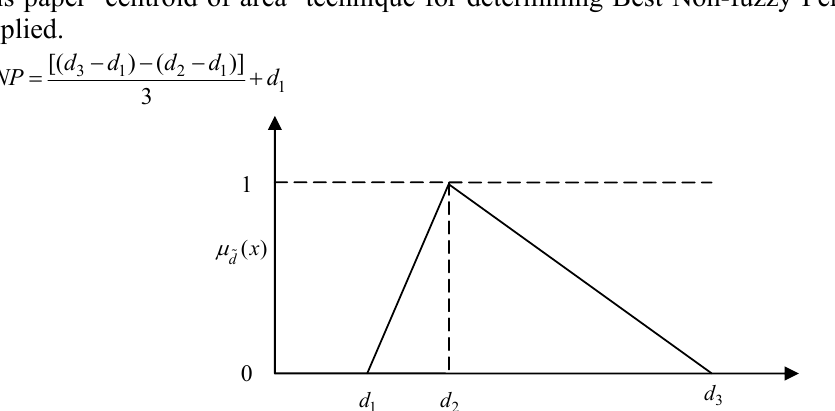
Fig. 1. Membership function of a triangular fuzzy